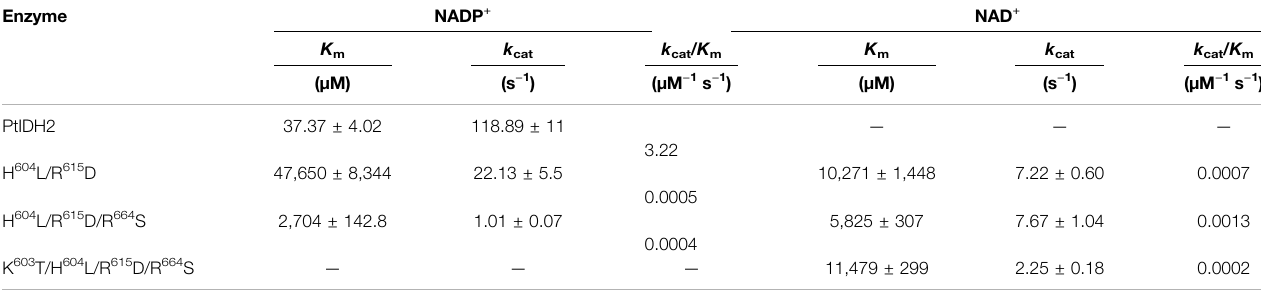
TABLE 2 | Kinetic parameters of wild-type PtIDH2 and those of its mutant forms.